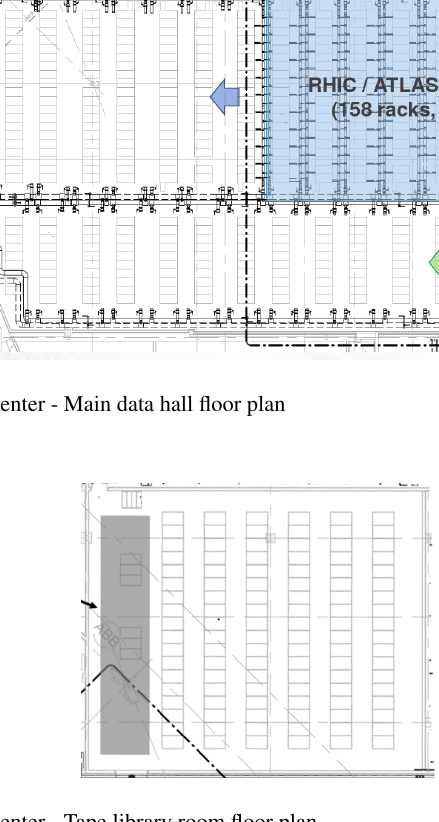
Figure 3. New Data Center - Tape library room floor